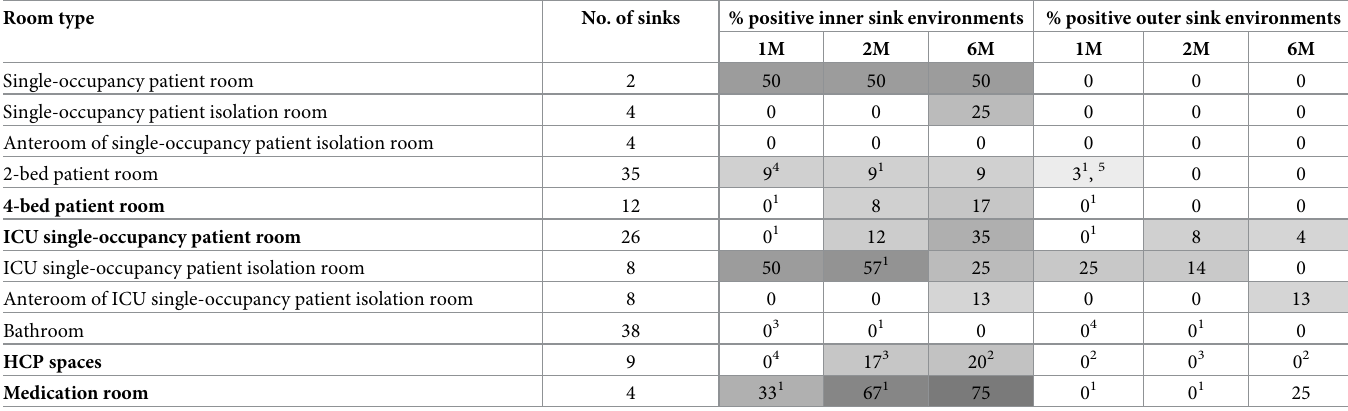
Table 2. Heat map showing the percentages of VIM-PA-positive samples at one, two, and six months after the intervention per room type. Room